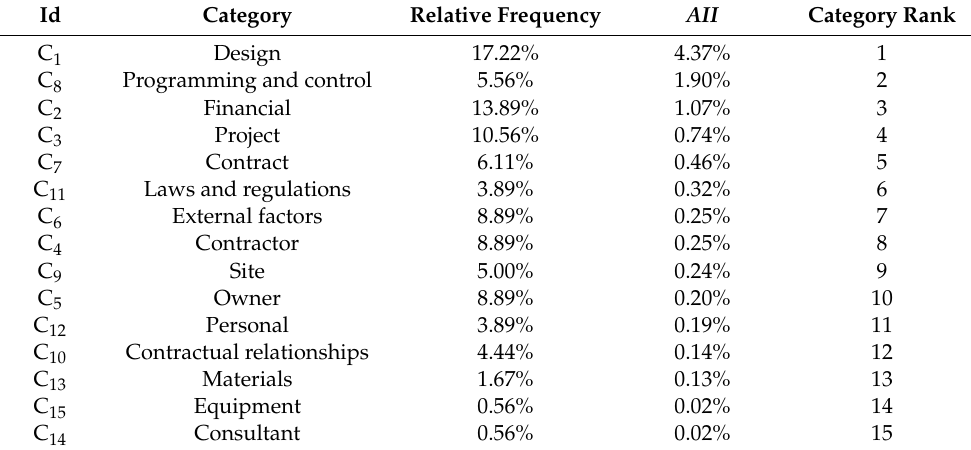
Table 8. Top cost overrun categories according to the Average Influence Index ( AII ).